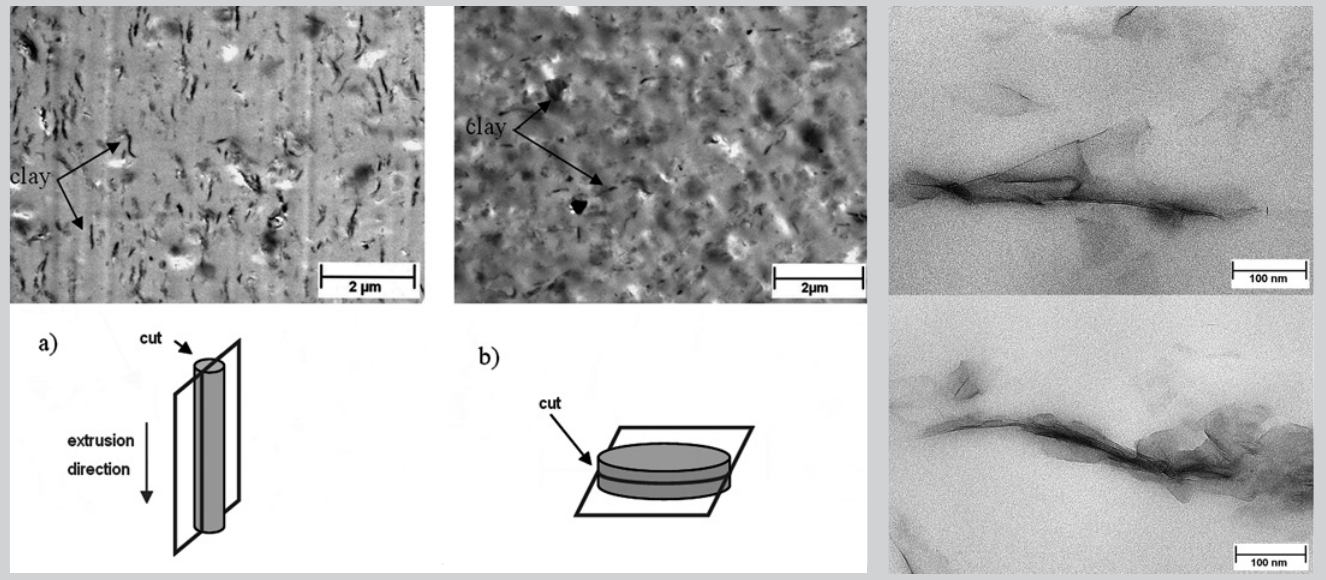
Figure 1 (left): TEM-analysis of PMMA / nano-clay composites (4.1 vol% clay) after sample preparation a) extruded sample for elongation, b) compression-molded sam- ple for shear. Figure 2: TEM-analysis of PMMA / nano-clay with 4.1 vol% clay (extruded sample for elon-